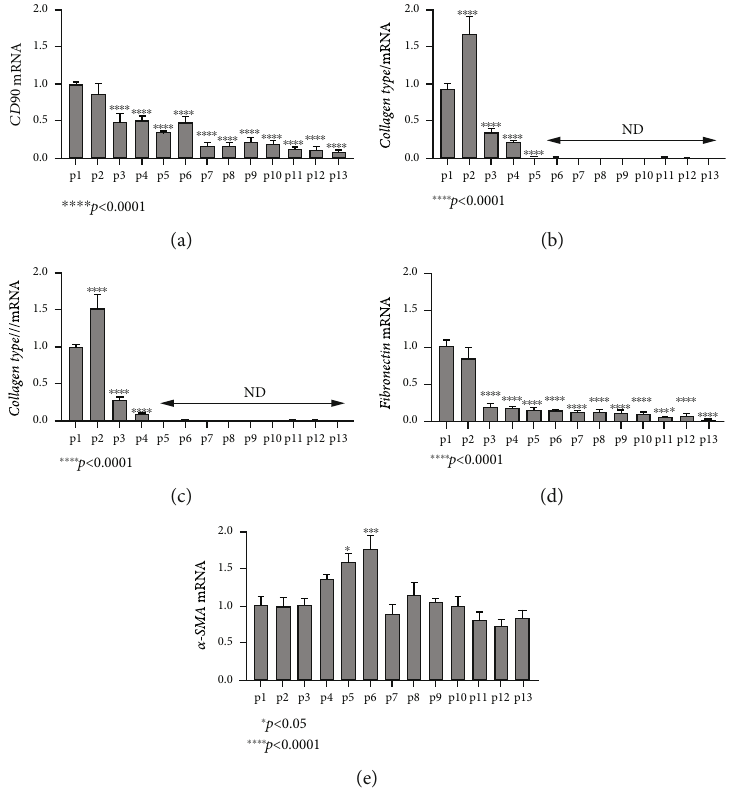
Figure 3: Expression of mesenchymal markers and ECM components during passaging. The mRNA levels of CD90, collagen types I and III, and fi bronectin were gradually reduced after passage 2 (a – d), with the exception of α -SMA, which showed a tendency to increase during passages 4-6, but later decreased to basal levels (e). ND: nondetectable. All experiments were performed in triplicate. The gene expression of each studied gene was normalized against GAPDH gene expression in the same sample using the 2 - ΔΔ Ct method. Passage 1 expression levels were set as a reference point, and expression levels in later passages were compared to that. Data are presented as the mean ± standard errorof themean ð SEM Þ